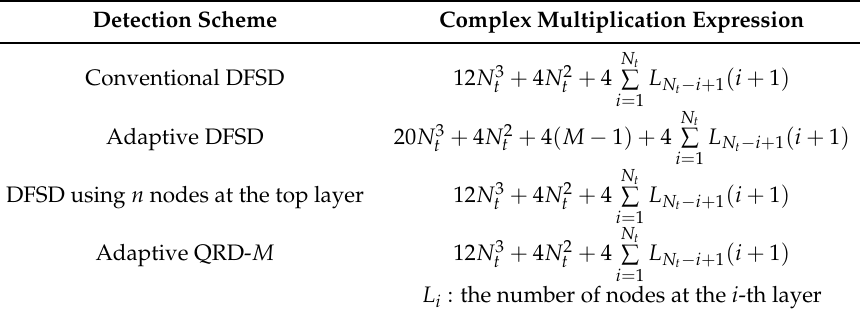
Table 1. The complex multiplication expression according to detection schemes.